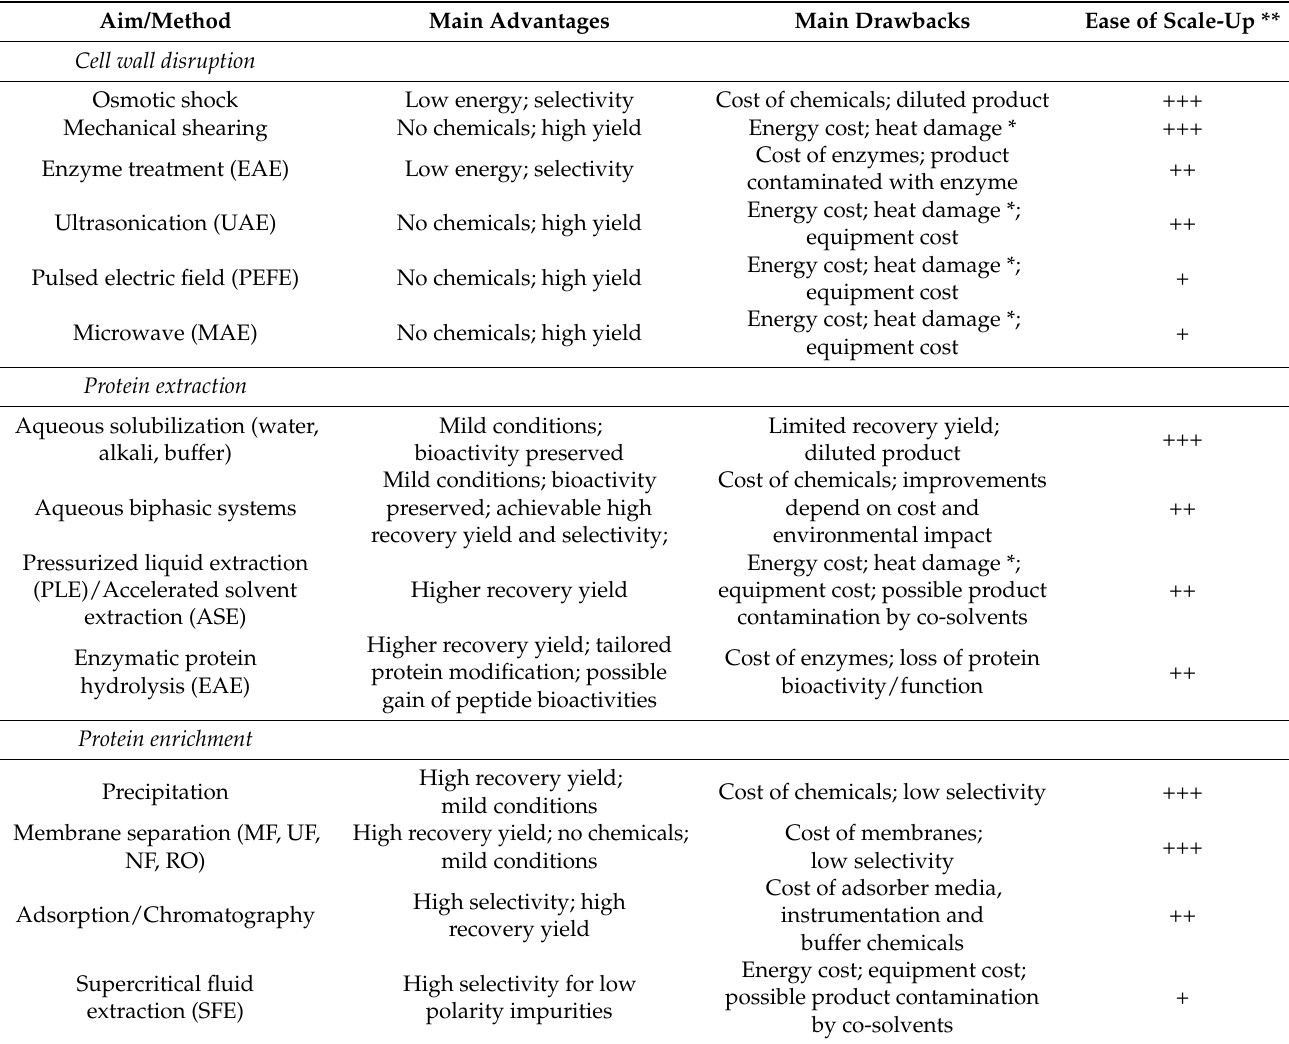
Table 8. Comparison of the relevant aspects of protein extraction